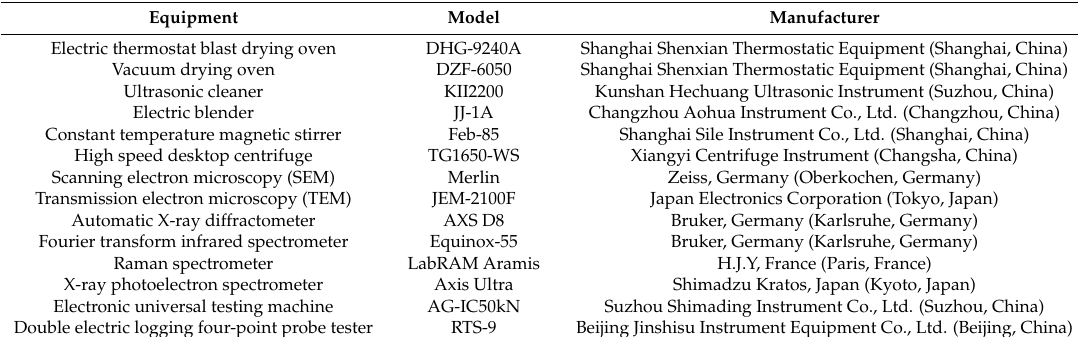
Table 2. Experimental